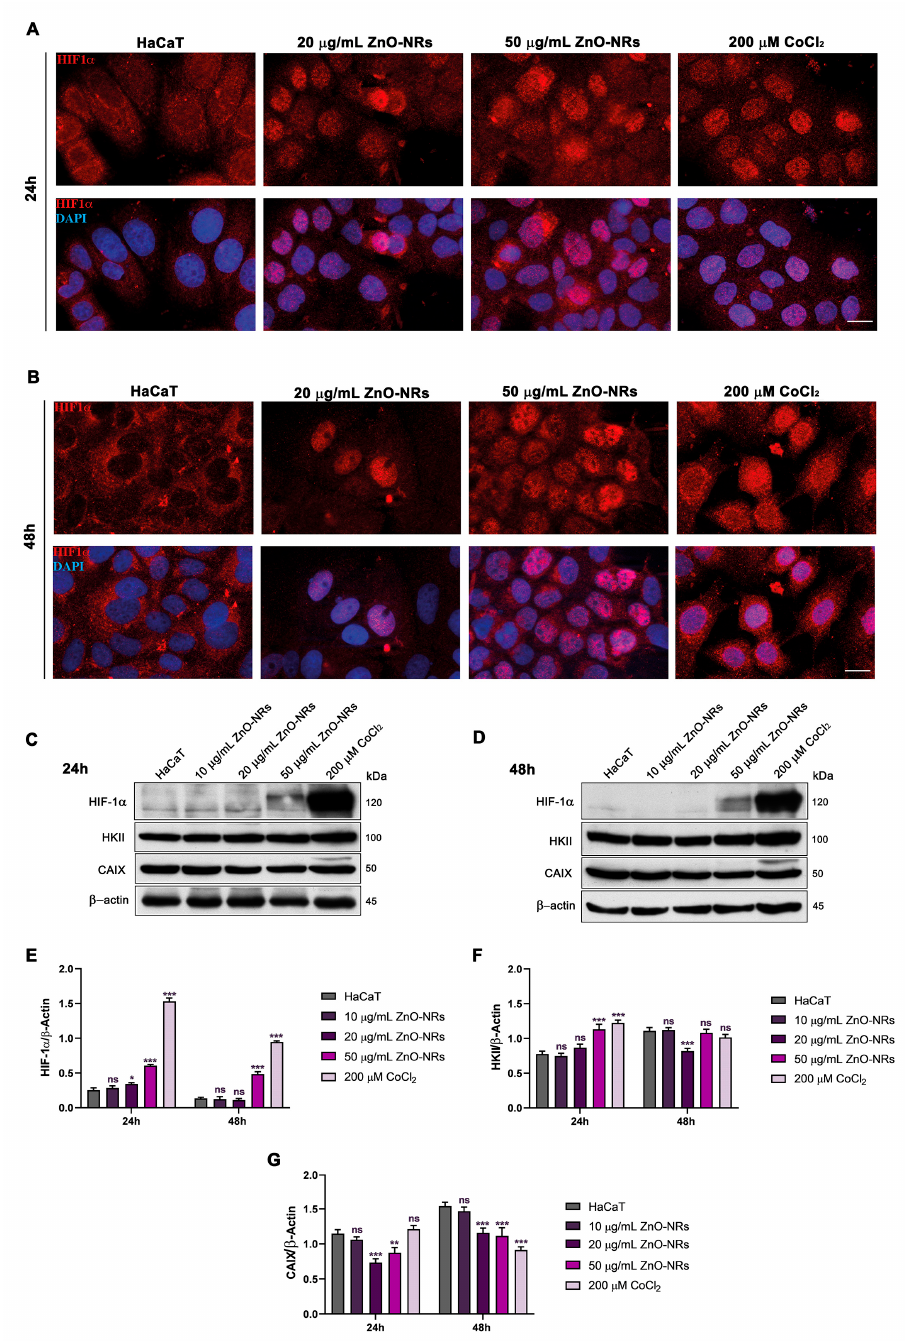
Figure 4. ZnO-NRs’ effects on HIF-1 α expression and localization in HaCaT cells. HaCaT cells were either untreated or treated with the indicated ZnO-NR concentration for 24 and 48 h. ( A ) HIF-1 α nuclear translocation (red fluorescence) after 24 h treatment with 20 and 50 µ g/mL ZnO-NRs. Nuclei were stained with DAPI (blue fluorescence), 40 × magnification. ( B ) HIF-1 α nuclear translocation (red fluorescence) after 48 h treatment with 20 and 50 µ g/mL ZnO-NRs. Nuclei were stained with DAPI (blue fluorescence), 40 × magnification. ( C , D ) HIF-1 α , hexokinase II (HKII), and carbonic anhydrase IX (CAIX) protein expression after 24 and 48 h treatment with 10, 20, and 50 µ g/mL of ZnO-NRs. ( E – G ) Densitometric analysis of HIF-1 α , HKII, and CAIX protein expression after 24 and 48 h treatment with 10, 20, and 50 µ g/mL ZnO-NRs. Experiments were repeated three times. * p < 0.05, ** p < 0.01, and *** p < 0.001. ns, not significant. In all experiments, hypoxia, induced by 200 µ M CoCl 2 , was used as positive control. β -actin was used as loading